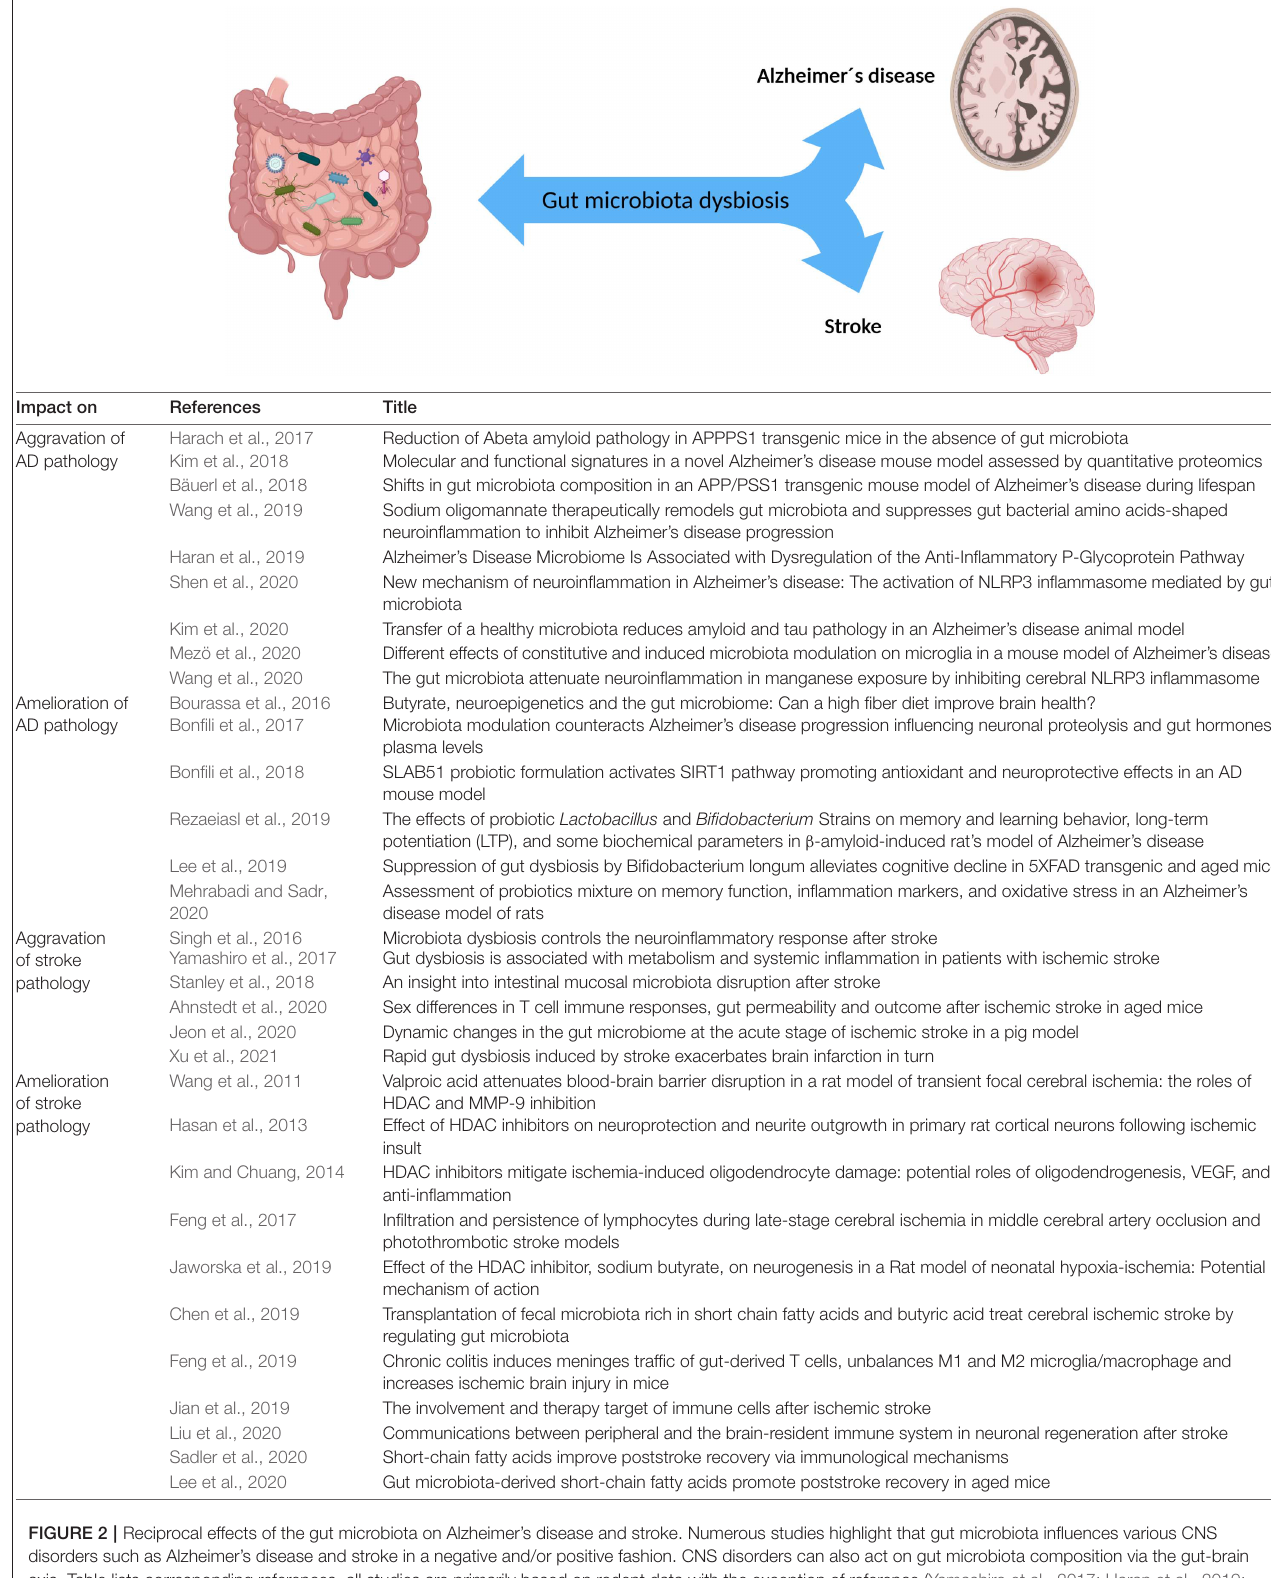
Frontiers in Cellular Neuroscience |